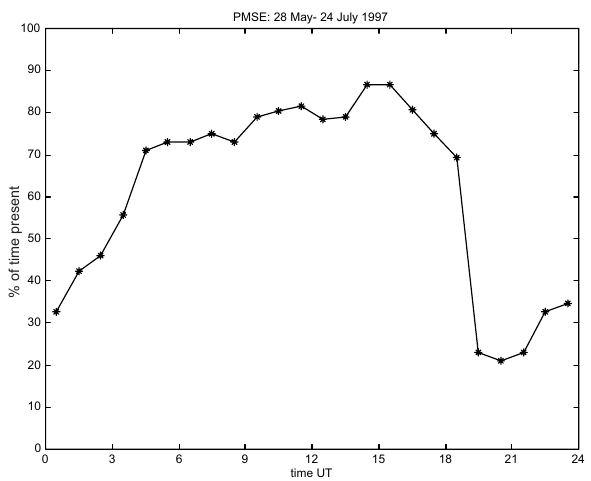
Fig. 1. Occurrence rate of PMSE during the period 28 May–24 July 1997 as a function of time of